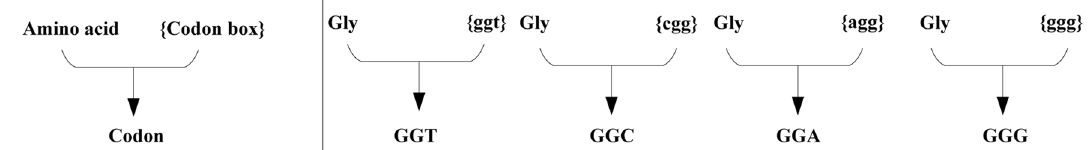
Figure 1. One-to-one mapping of amino acids and codon boxes with codons. An example of how an amino acid (Gly and its corresponding codon box can uniquely determine a